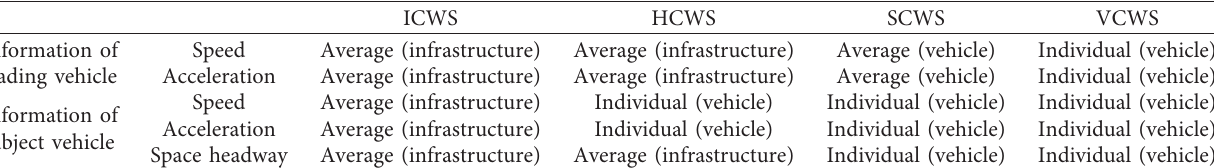
Table 1: Data source for four collision warning systems.